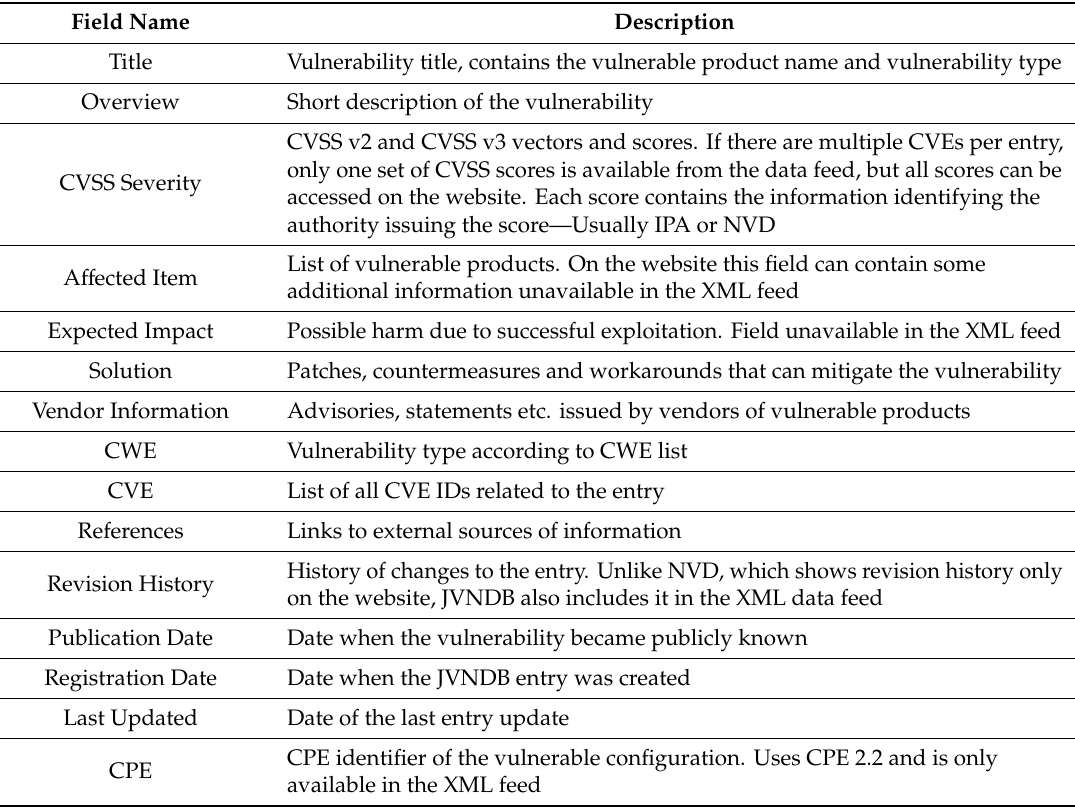
Table 9. Description of data fields available in the JVNDB